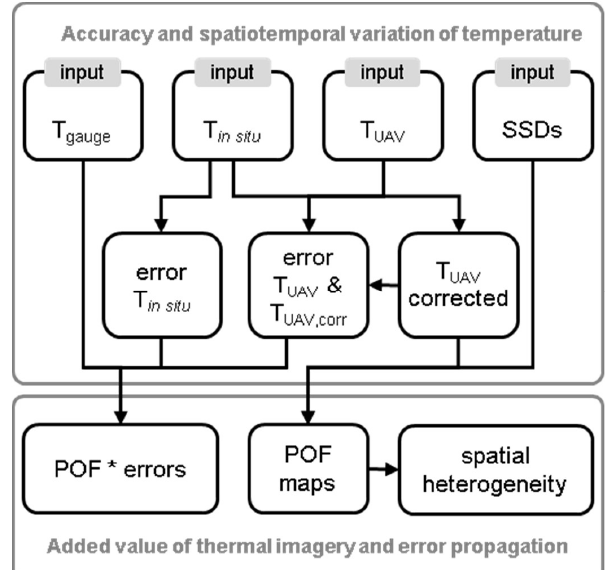
Figure 1. Flowchart to determine the accuracy of thermal imagery, calculate habitat suitability and to quantify the effect of the error in temperature on the POF estimations (T: temperature; UAV: unmanned airborne vehicle; SSD: species sensitivity distribution, POF: potentially occurring fraction).